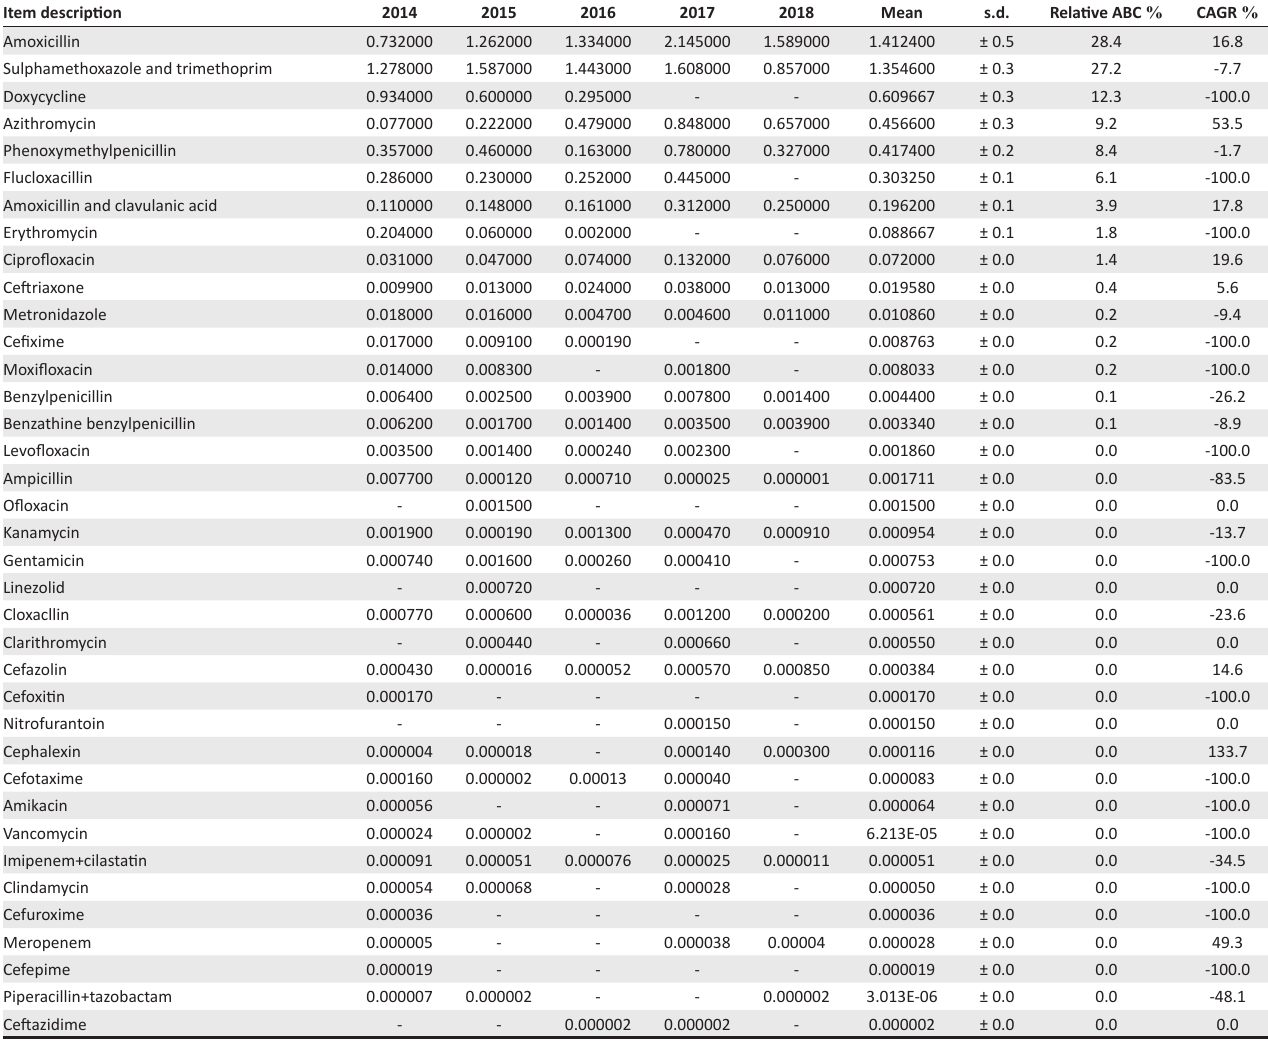
TABLE 1-A1: Absolute antibiotic consumption at Anatomical Therapeutic Chemical level 5 in defined daily dose per 1000 inhabitants per day, mean and compound annual growth